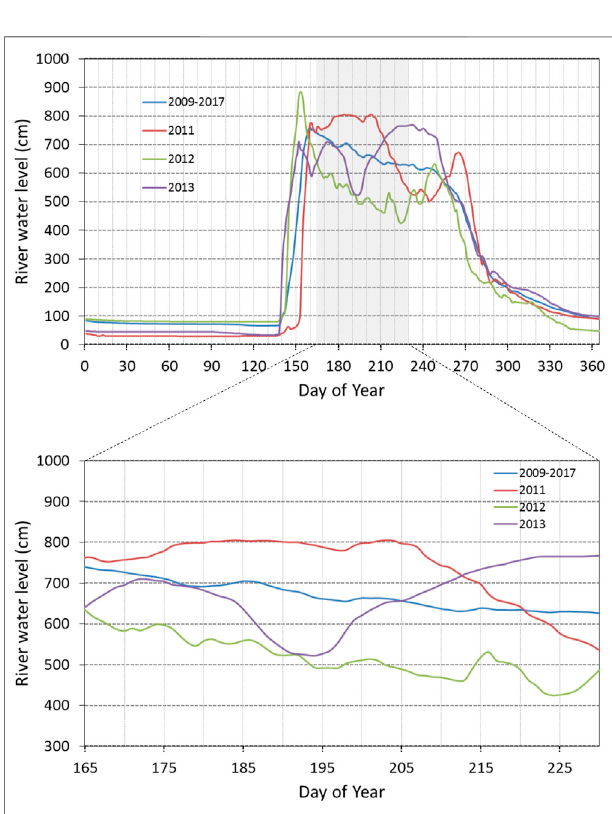
FIGURE 7 | Seasonal and interannualvariations in the river water level of Indigirka mainstream at CKH during 2009 – 2017. The data are from Tei et al. (2020). The blue line denotes the temporal average of the river water level during 2009 – 2017, and the red, green, and purple lines show the river water level in 2011, 2012, and 2013,